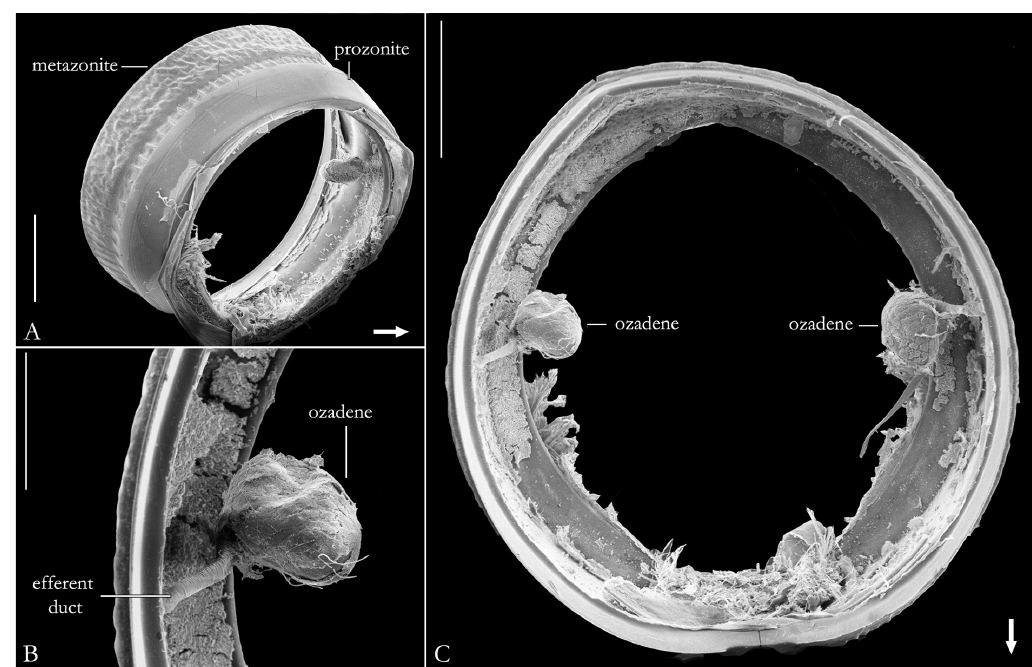
Fig. 27. SEM images of midbody rings of Pseudonannolene granulata sp. nov. (MNRJ). A . Lateral view. B . Detail of the ozadene. C . Midbody ring in transversal view. Scale bars: A, C = 1 mm; B = 0.5 mm.